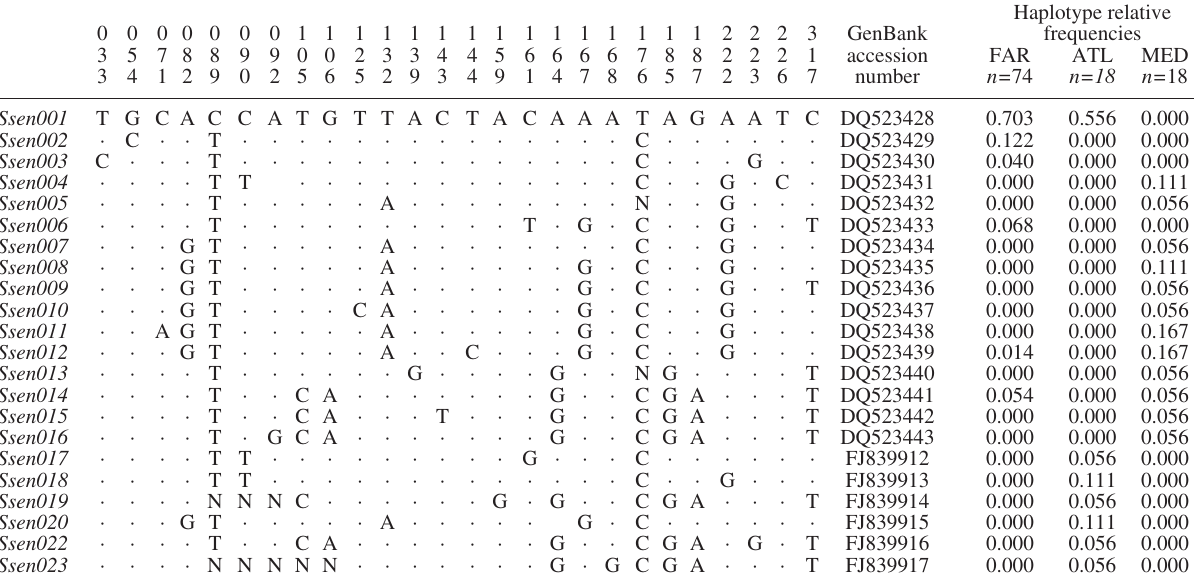
Table 2. – Solea senegalensis mtDNA CR-I haplotypes ( Ssen# ) defined by the variable nucleotide positions (numbers above sites), their corresponding NCBI’s GenBank accession numbers, and relative frequencies in farmed (FAR), wild Atlantic (ATL) and wild Mediterranean (MED) sole. Sampling details in Materials and Methods. Identity with sequence Ssen001 is indicated by dots (·), and ambiguous nucleotides positions by the letter N.